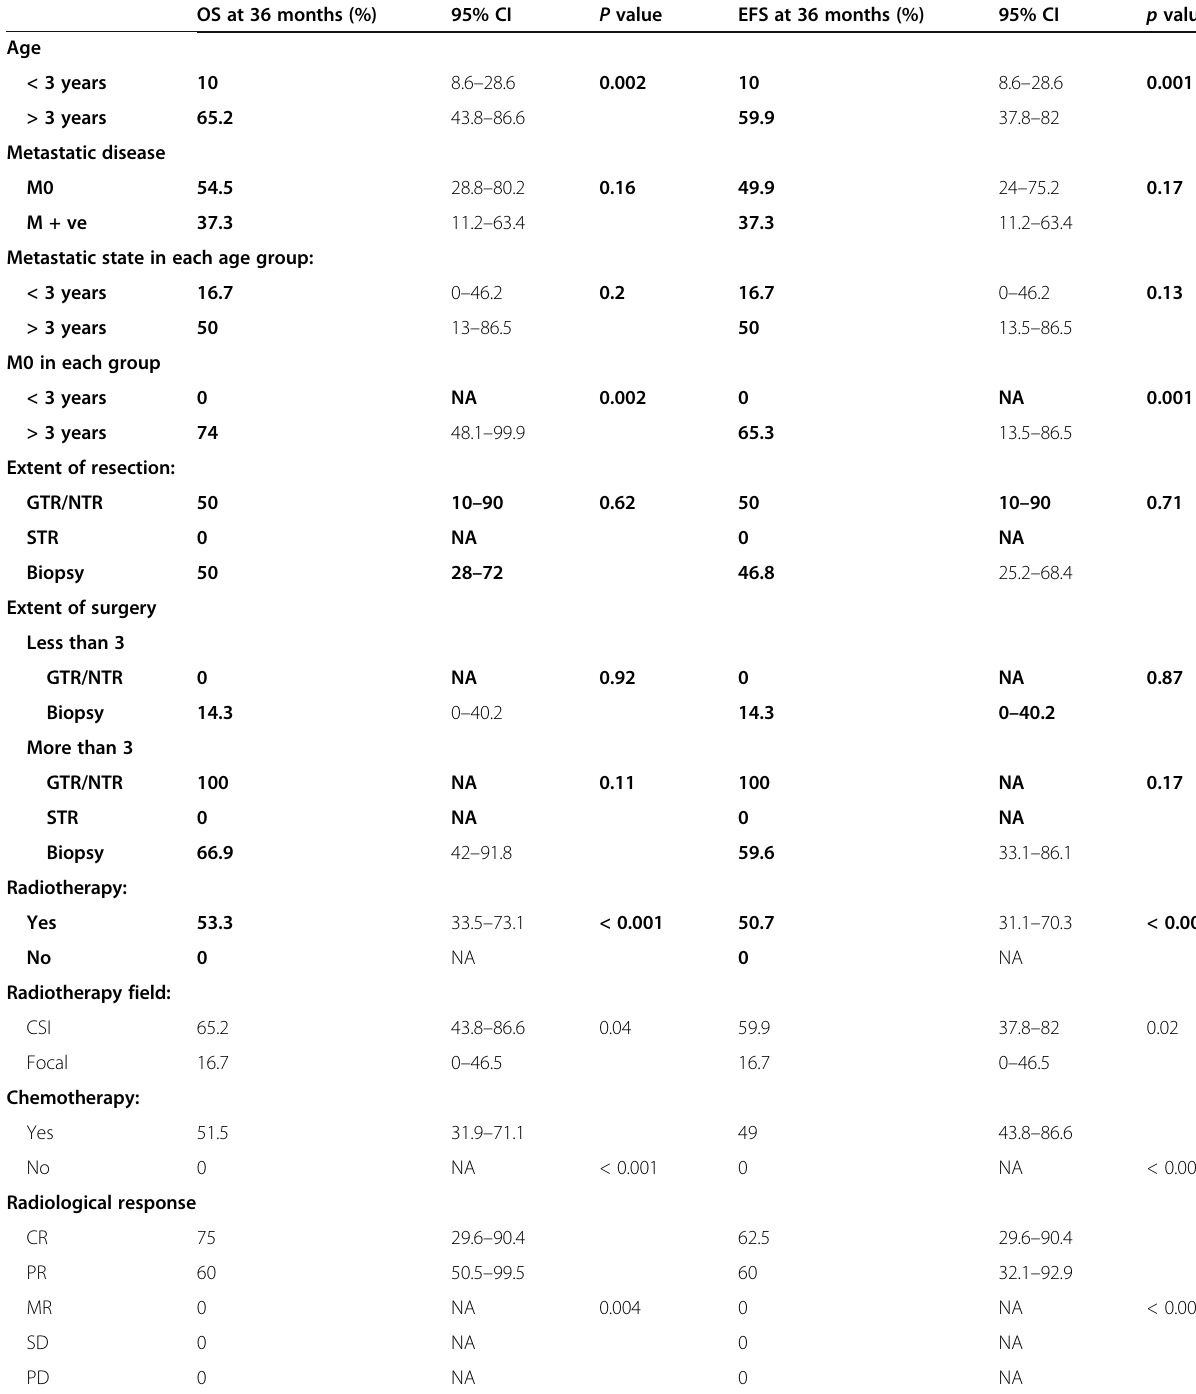
Table 2 Correlation between different prognostic factors and survival OS at 36 months (%) 95% CI P